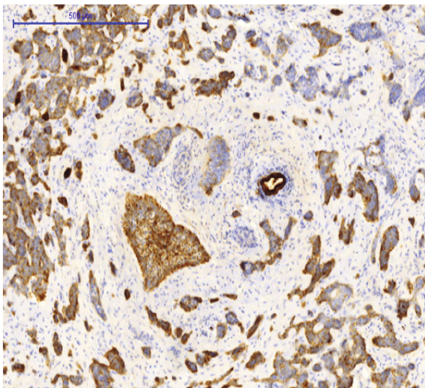
Figure 6: P63 immunohistochemical staining. Hepatic BSCC show- ing intense staining. Tumor cells are positive, whereas the benign bile duct in the center is negative.